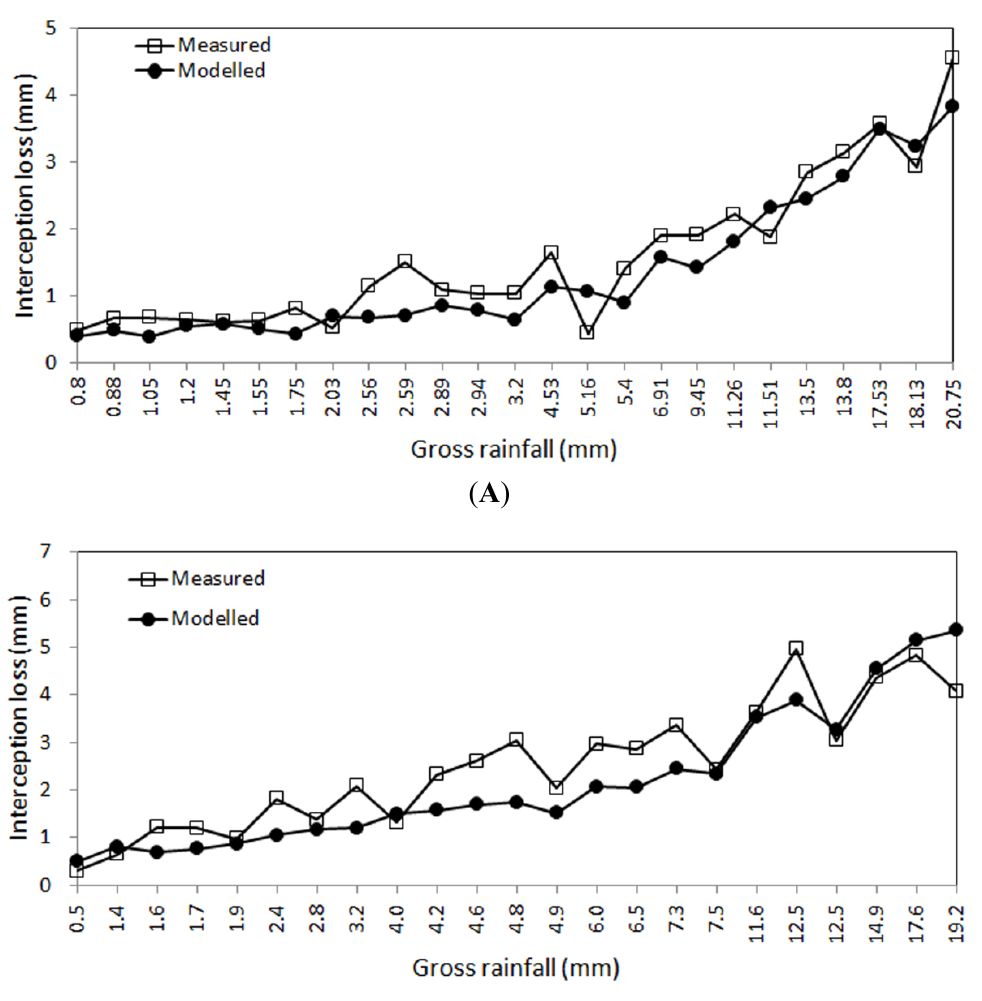
Figure 4. Correlation between the interception loss and the ground observed gross rainfall at the two sites for the period from 13 June to 7 October 2008. ( A ) The Dayekou experimental site; ( B ) The Pailugou experimental